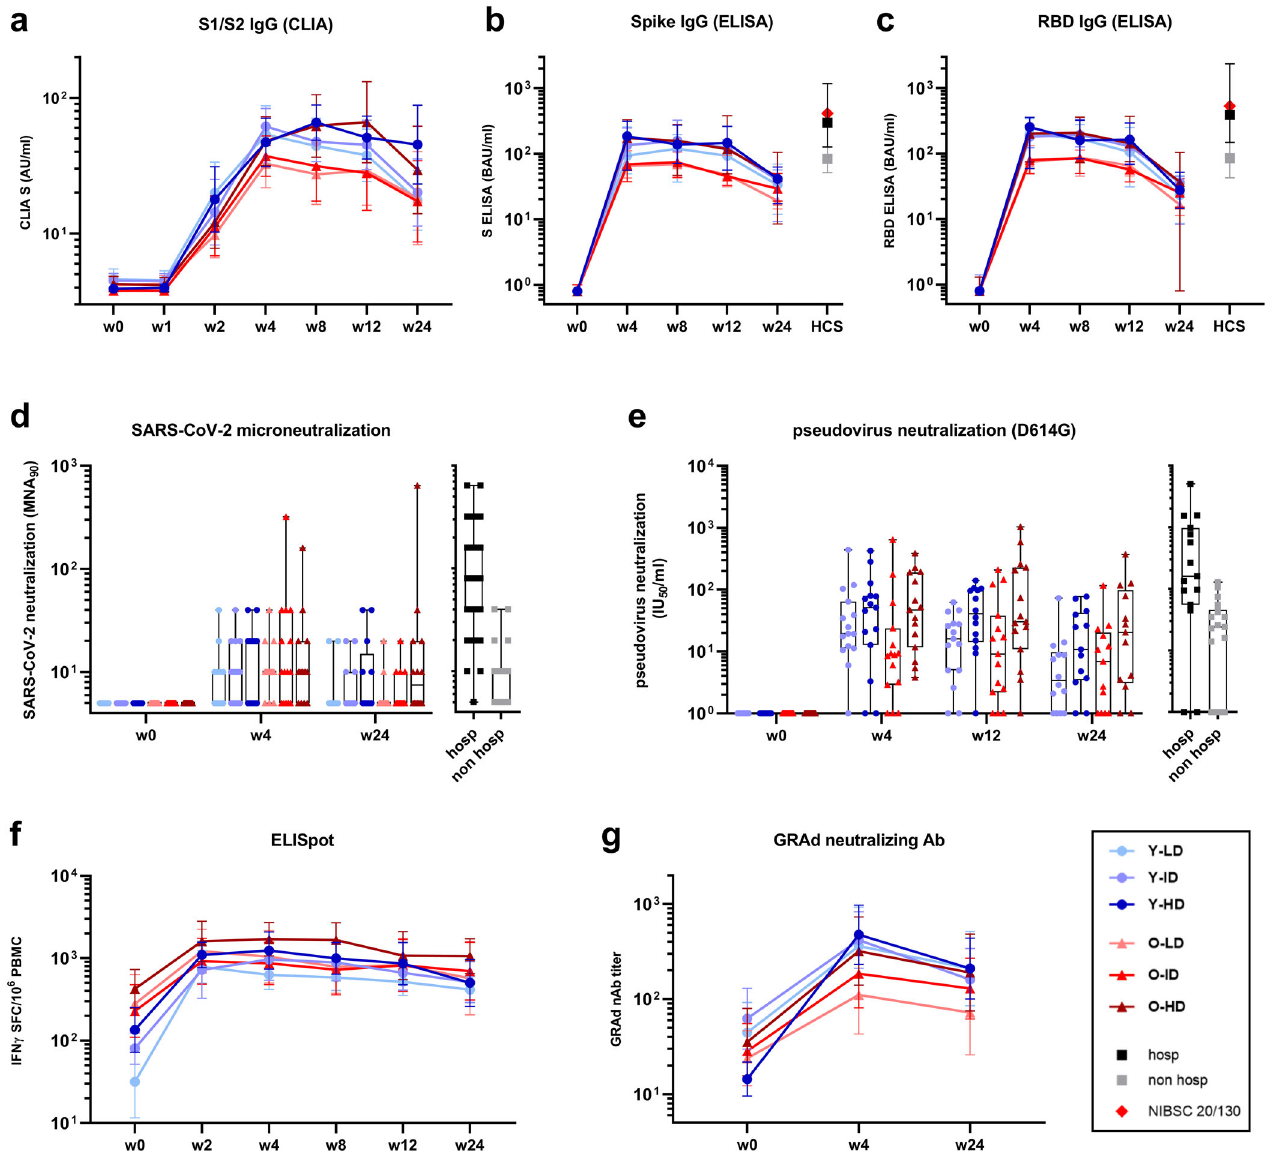
Fig. 1 SARS-CoV-2 humoral, cellular and anti-vector response elicited by GRAd-COV2 vaccination over time. SARS-CoV-2 humoral, cellular and anti-vector response induced by GRAd-COV2 vaccination and measured at the day of vaccination (w0) and 1, 2, 4, 8, 12 and 24 weeks (w1, w2, w4, w8, w12, w24 respectively) after vaccination over 6 months follow up. N = 15 for each study arm. a IgG binding to S1-S2 measured by CLIA. Data are expressed as arbitrary unit (AU)/ml. b SARS-CoV-2 speci fi c IgG measured by ELISA on recombinant full-length spike protein. c SARS-CoV-2 speci fi c IgG measured by ELISA on RBD. Data in both b and c are expressed as binding antibody units (BAU)/ml. d Neutralizing activity detected by SARS-CoV-2 microneutralization assay. e Neutralizing activity detected by Spike (D614G)-pseudotyped lentivirus neutralization assay. SARS-CoV-2 neutralization titers are expressed as MNA 90 , or the reciprocal of serum dilution achieving 90% neutralization, or in International Units (IU)ml, in d and e respectively. f Spike-speci fi c T cell response measured by IFN γ ELISpot on frozen PBMC. Data are expressed as IFN γ spot forming cells (SFC) per 10 6 PBMC. g Neutralizing titers to the GRAd vector, measured by a neutralization assay based on SEAP reporter gene activity inhibition. Throughout, blue and red color shades identify younger (Y-circles) and older age (O-triangles) cohorts, respectively, and color tone increase with vaccine dose: low dose (LD, 5 × 10 10 vp), intermediate dose (ID, 1 × 10 11 vp) and high dose (HD, 2 × 10 11 vp). Square symbols indicate human convalescent serum obtained from either previously hospitalized (hosp-dark gray) or from non- hospitalized (non-hosp-light gray) COVID-19 patients. NIBSC 20/130 research reagent plasma (red diamond) is shown for reference (panels b to c ). Data are shown either as the group geometric mean and 95% con fi dence interval (CI) (panels a , b , c , f and g ) or as individual points and box and whiskers indicating median and interquartile range, with whiskers ranging from min to max (panels d and e ). Negative samples were assigned a value of ½ the